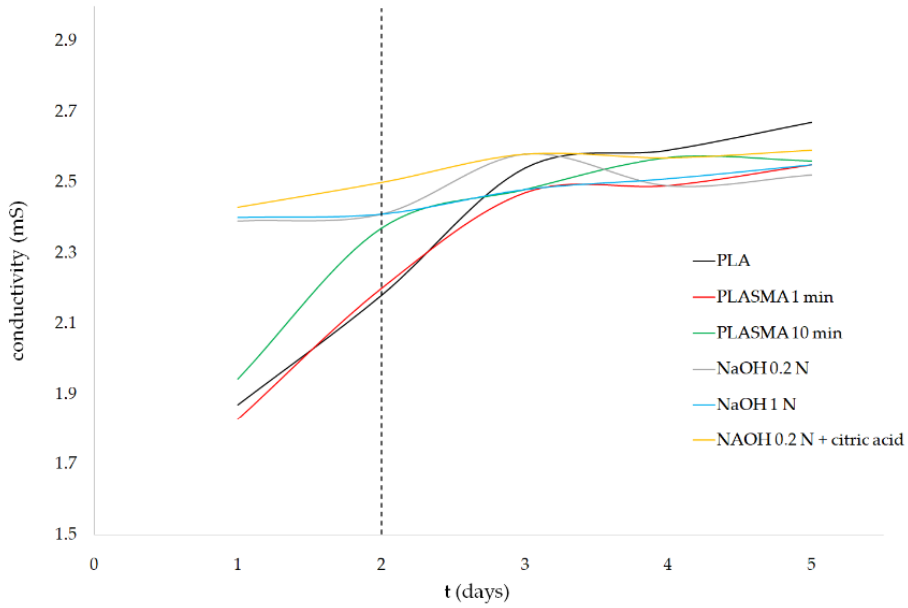
Figure 6. Enzymatic degradation test results of surface-treated samples: conductivity variation.